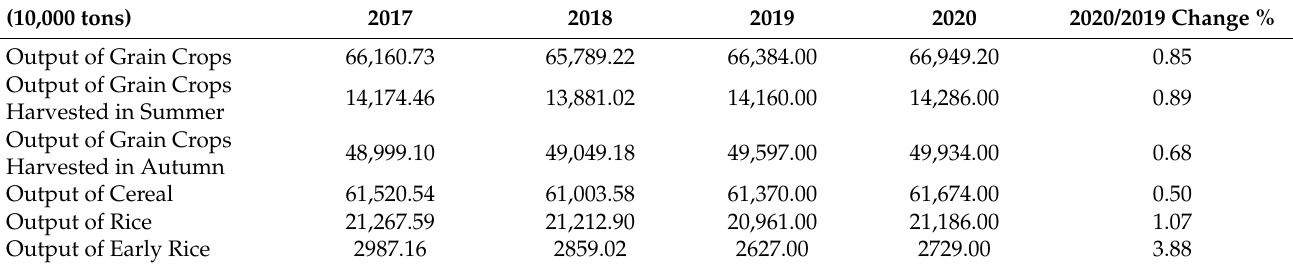
Table 5. Grain crops and rice output changes.